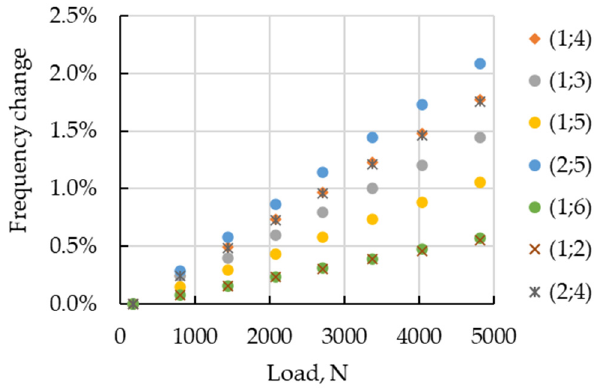
Figure 7. Percentage change increase versus tensile force.